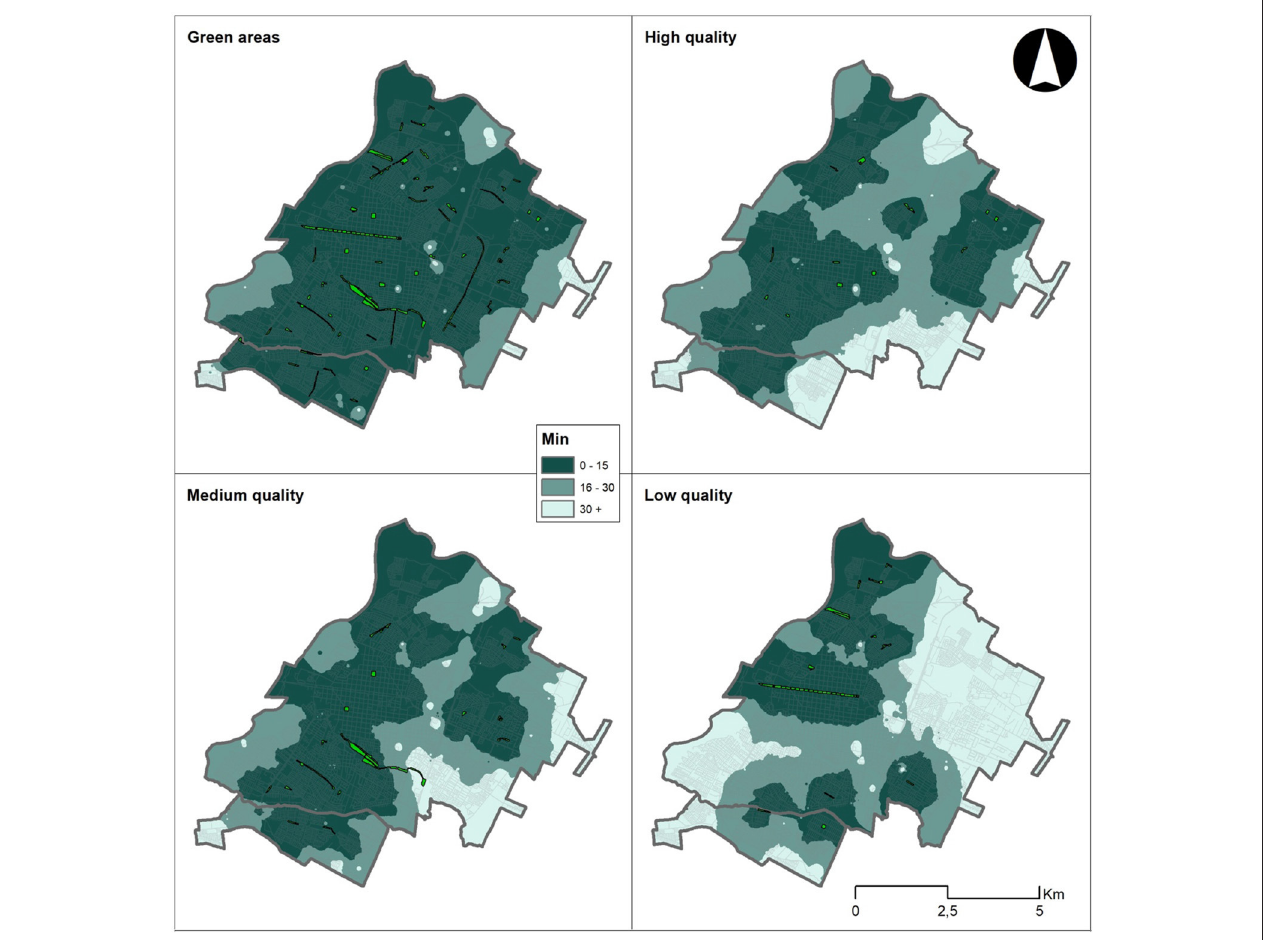
FIGURE 5 | Accessibility of urban green spaces in Talca, for all green areas (top left), and according to quality